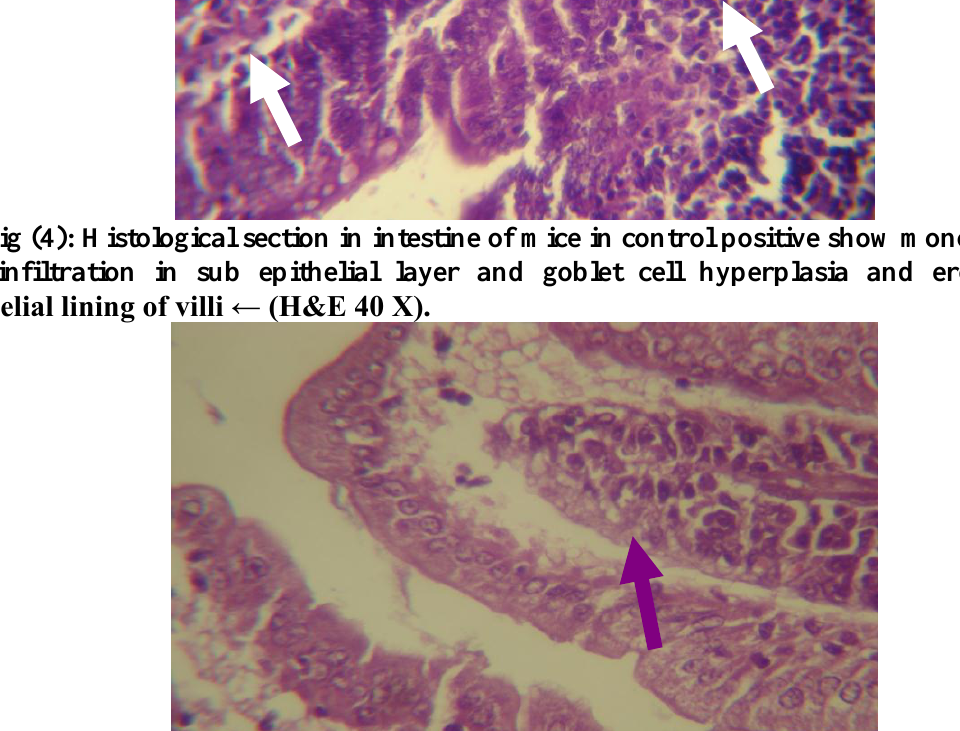
Fig (5): Histological section of mice intestine in treated group there was no clear pathology lesion except mononuclear cell in lamina properia ← (H&E 40